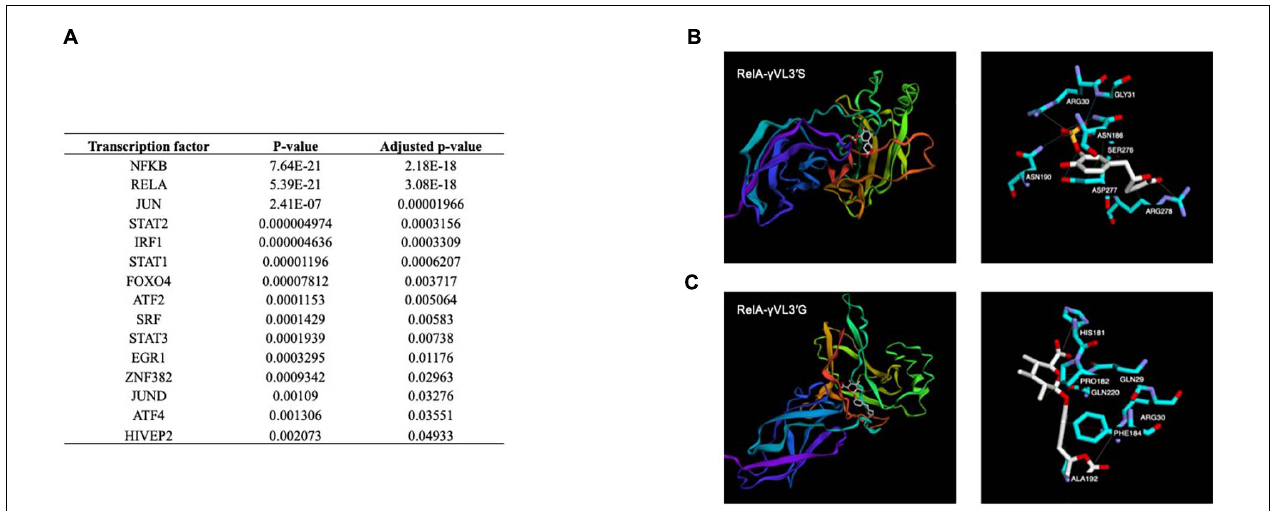
FIGURE 8 | Transcription factors potentially involved in the nutrigenomic modifications induces by γ -valerolactones and their in silico interaction with RelA subunit of NF- κ B. (A) List of potential transcription factors identified using bioinformatic analysis. Binding mode obtained by computational docking for: (B) 5-(4 (cid:48) -Hydroxyphenyl)- γ -valerolactone-3 (cid:48) -sulfate, and (C) 5-(4 (cid:48) -Hydroxyphenyl)- γ -valerolactone-3 (cid:48)